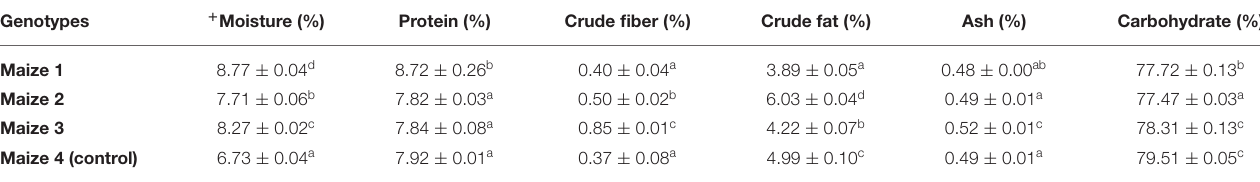
TABLE 4 | Chemical composition of ogi powder from PVA maize genotype and yellow landrace (control). Genotypes